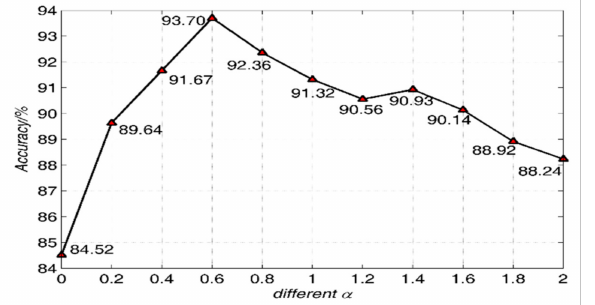
Figure 8. Classification performance of the ceramics with different α values for the Qionglai